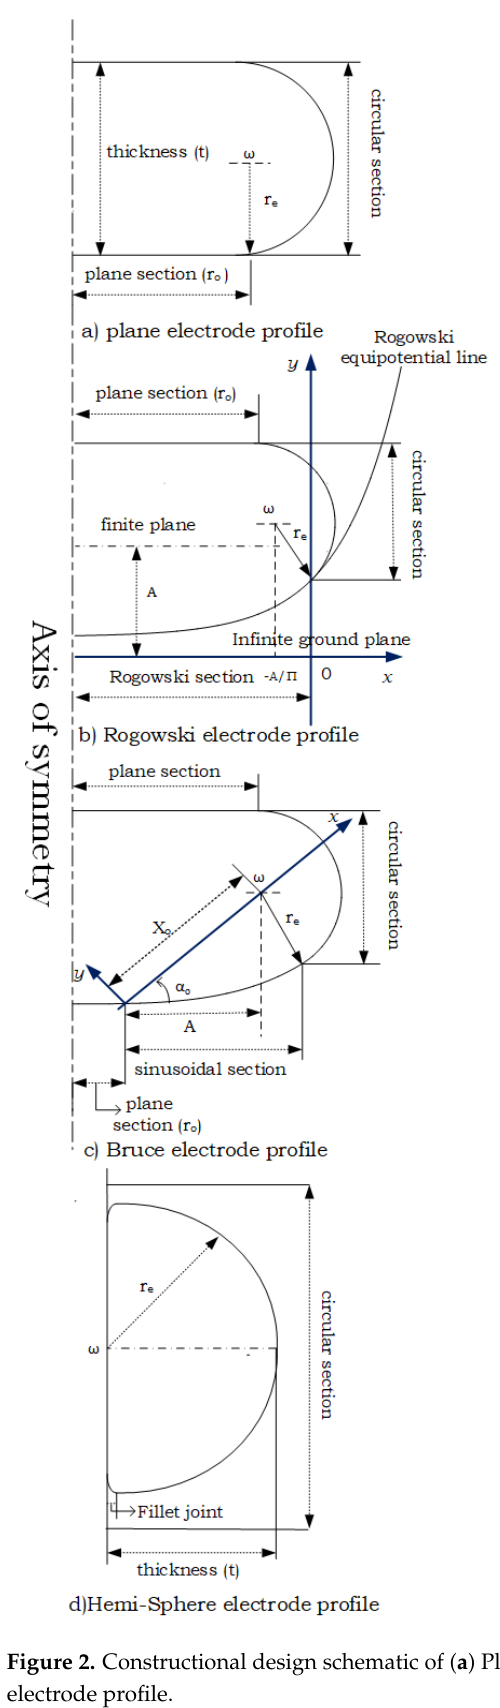
Figure 2. Constructional design schematic of ( a ) Plane, ( b ) Rogowski, ( c ) Bruce, and ( d ) Hemi-sphere electrode profile.